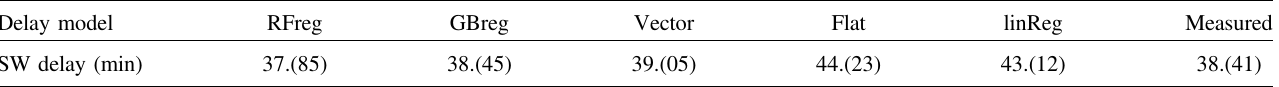
Table 2. Solar wind propagation delay predictions using all fi ve methods for the example CME on 2000/07/19 (see Fig. 1) with feature vector (248 R E , 13 R E , 18 R E , (cid:1) 556 km/s, (cid:1) 76 km/s, 91 km/s). The two digits after the decimal point are insigni fi cant, as the measurement error is in the order of 2